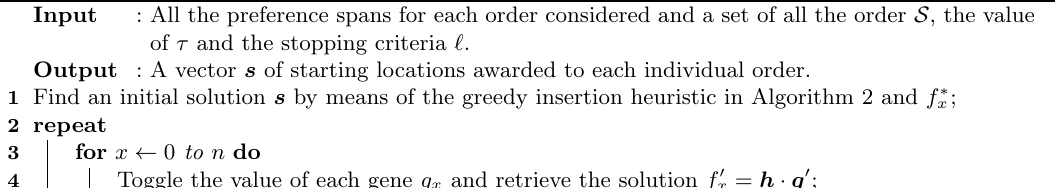
Algorithm 7 : Generalised extremal